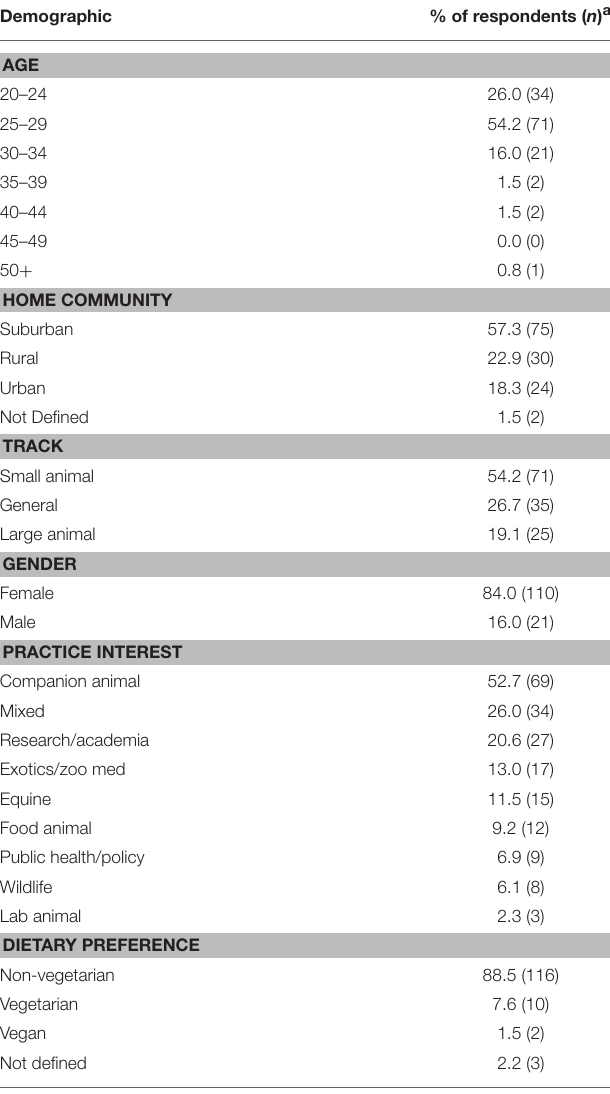
TABLE 1 | Summary of survey respondent demographics collected from the pre-course survey (% of total respondents ( n ); N = 131 a ).